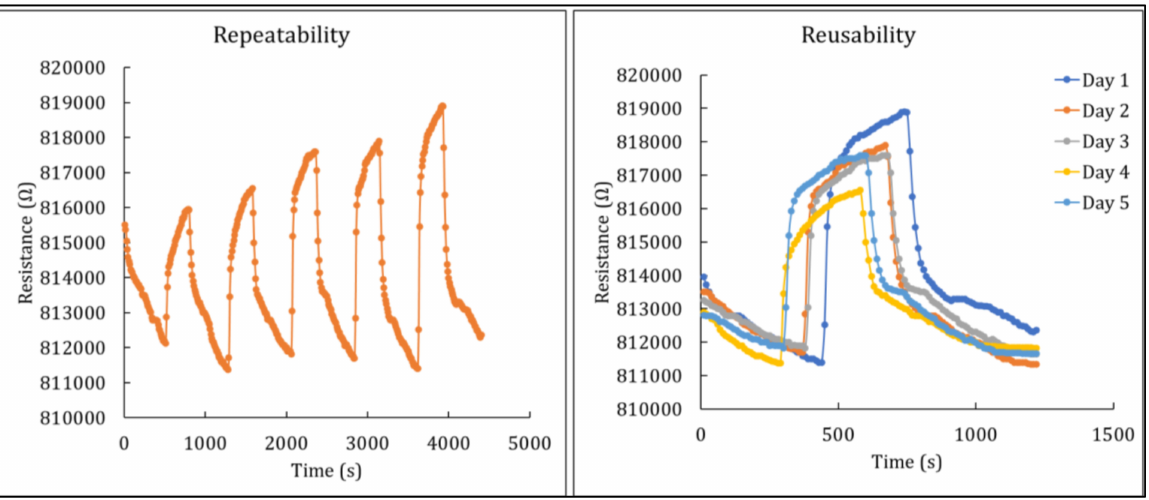
Figure 11. Repeatability and reusability characteristics of nickel ferrite–nanocellulose